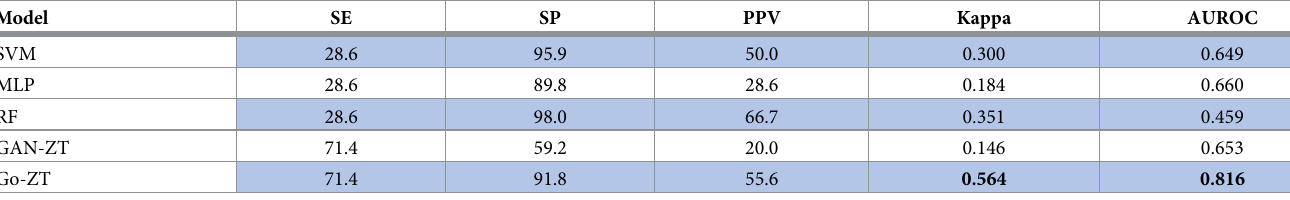
Table 3. Performances of different methods in activity prediction of test set chemicals. Model